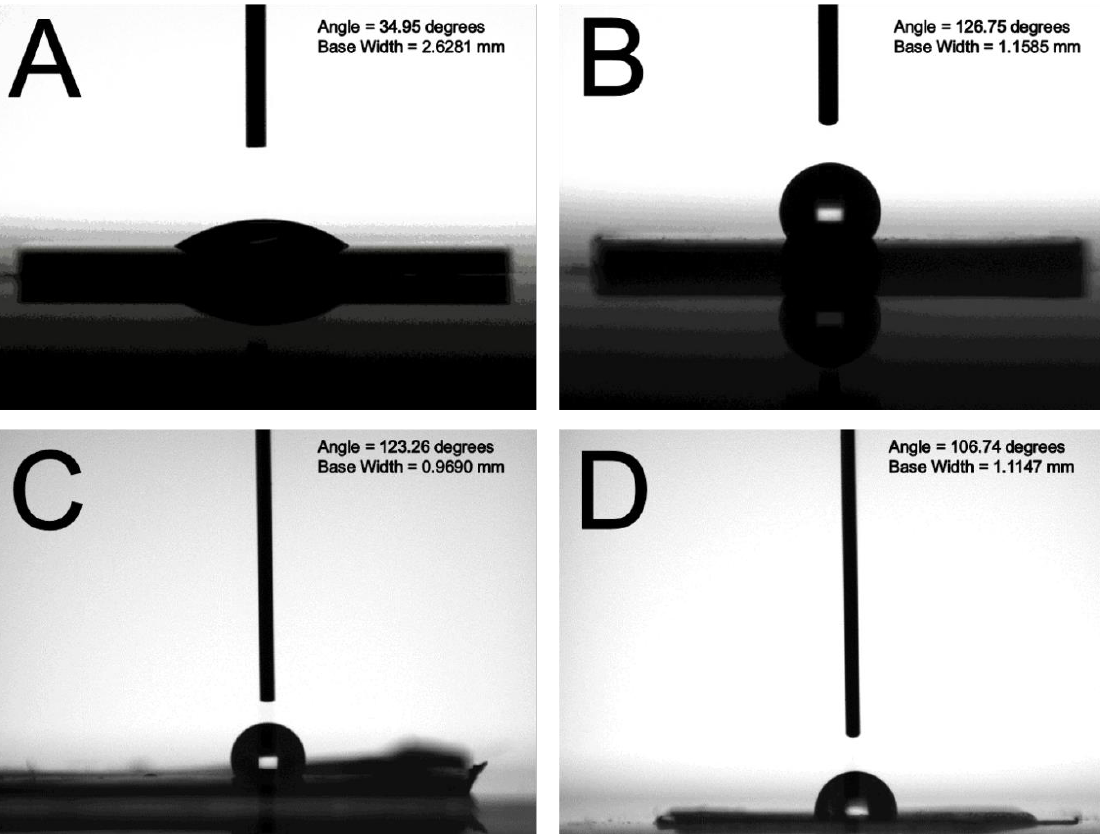
Figure 6. Water contact angles of ( A ) silicon substrate, ( B ) self-assembled binary nanocolloid array, ( C ) replicated soft mold, ( D ) imprinted nanofeatured film.